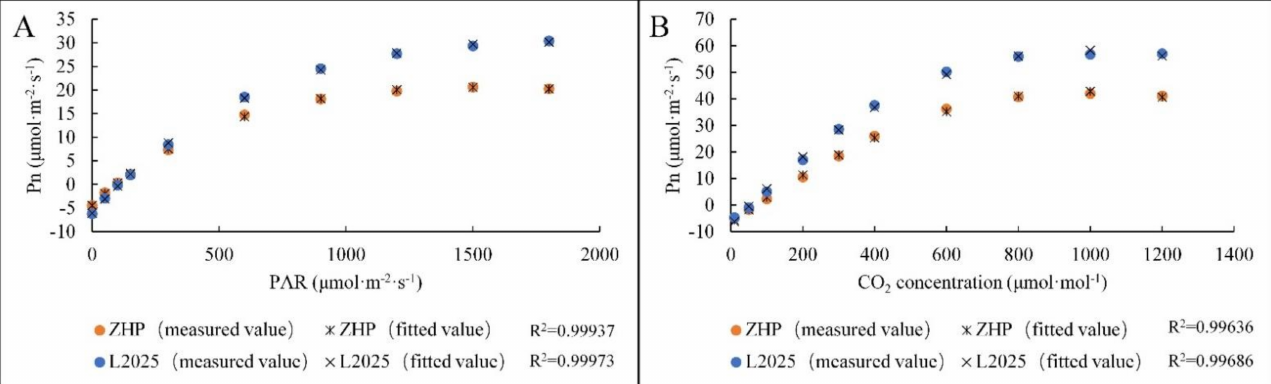
Figure 4. Model fitting of ( A ) Pn-PAR response curves and ( B ) Pn-CO 2 concentration response curves from leaves between ‘L2025’ and ‘ZHP’.